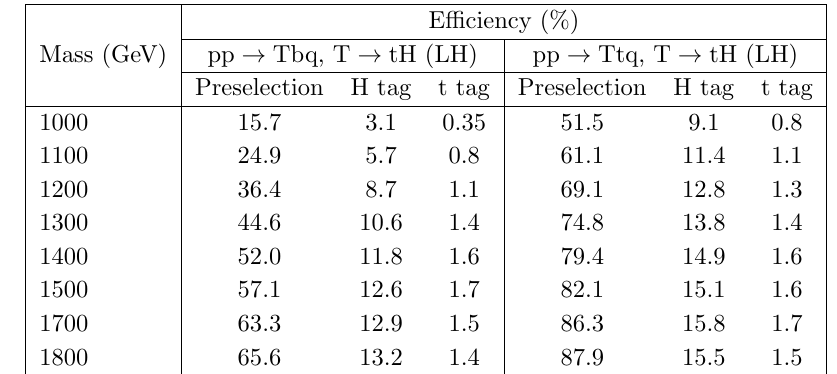
Figure 2 . The simulated M (T) distributions for the pp ! Tbq and the pp ! Ttq production modes with left-handed coupling for the T quark masses 1000, 1200, 1500, and 1800 GeV, after all selection criteria have been applied. The values of the product of the signal cross sections and the branching fraction B (T ! tH) are taken to be 1 pb.